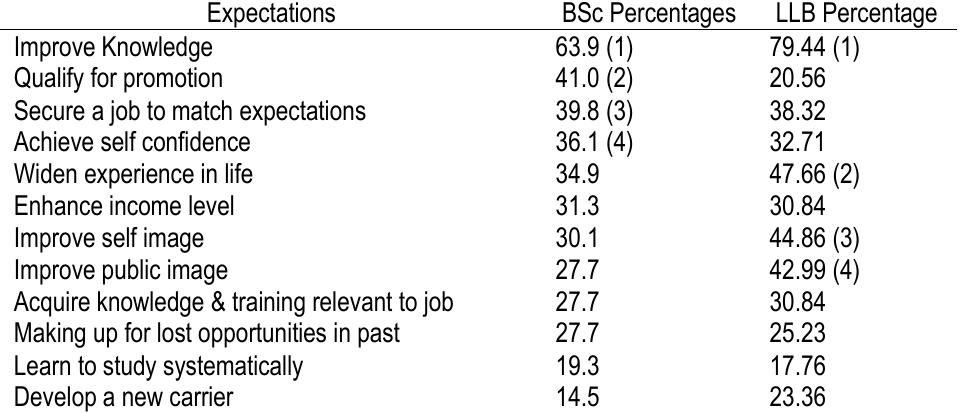
Table 2. Expectations at